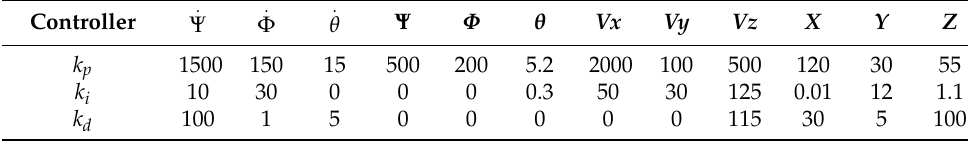
Table 5. Parameters of PID controller.